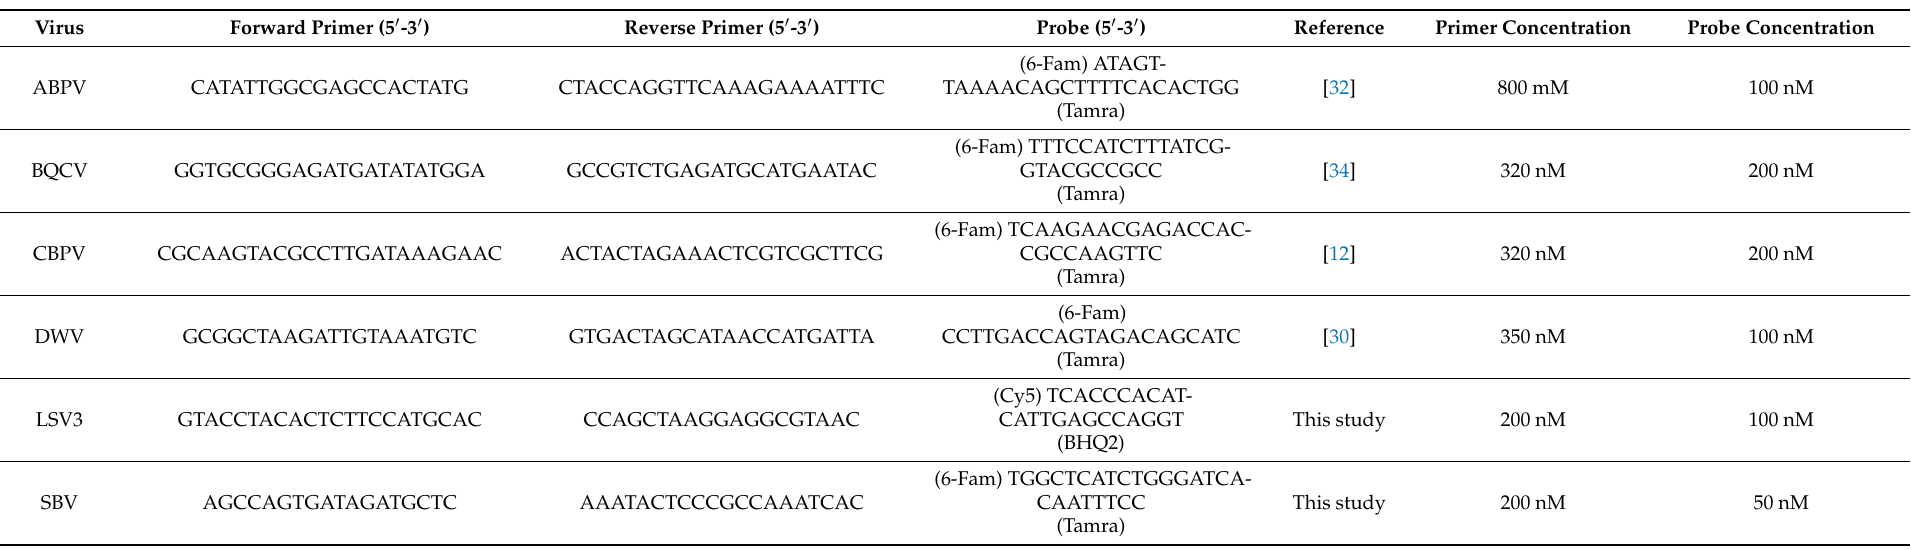
Table 1. Primers and TaqMan probes used for RT-qPCR